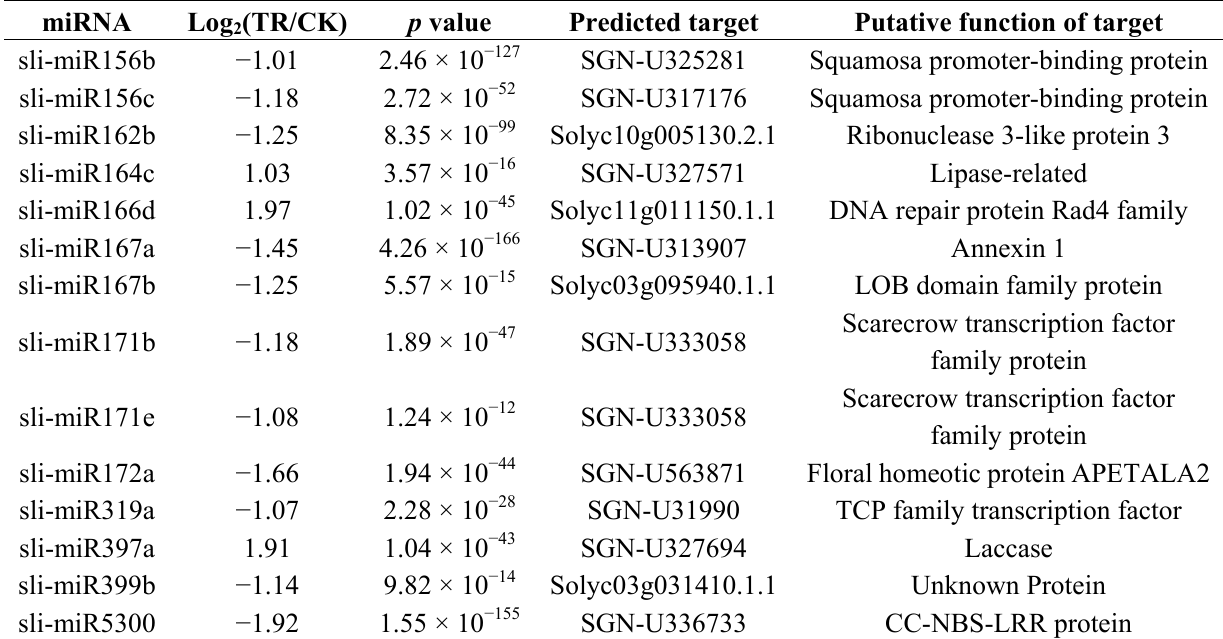
Table 2. NaCl-responsive miRNAs and their targets. The value of TR/CK is the ratio between normalized count from library TR and